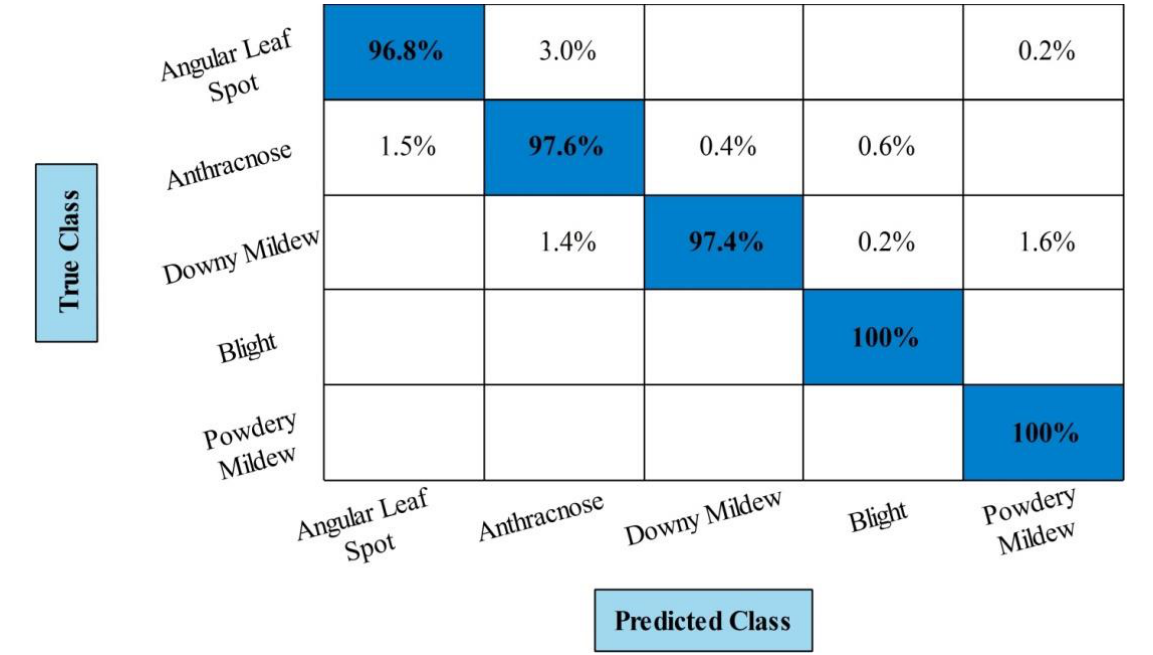
Figure 8. Confusion matrix of proposed framework of cucumber leaf diseases for Cubic SVM.